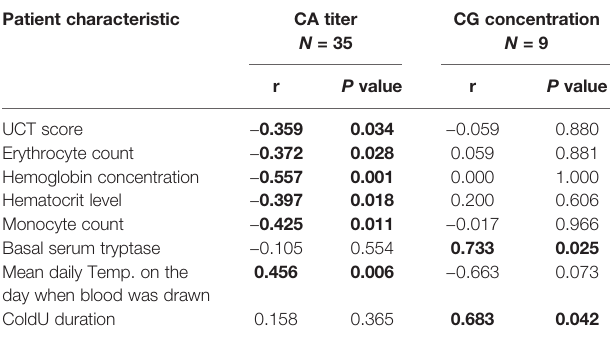
Statistically signi fi cant P values are in bold. CA, cold agglutinin; CG, cryoglobulin; ColdU, cold urticaria; N, number of patients; r, Spearman correlation coef fi cient; Temp., temperature; UCT, Urticaria Control